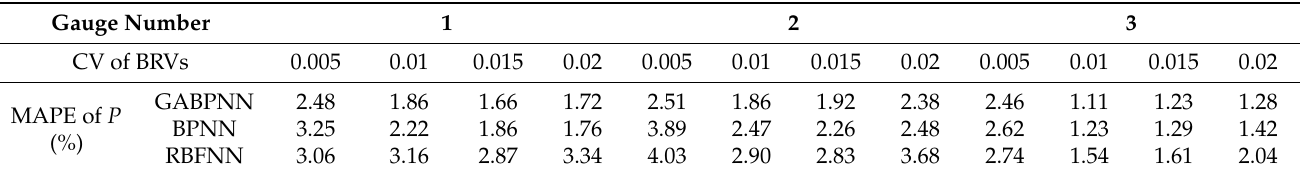
Table 12. The comparison of the test results of the ANNs in the DPR study under the shock load condition where v is 1000